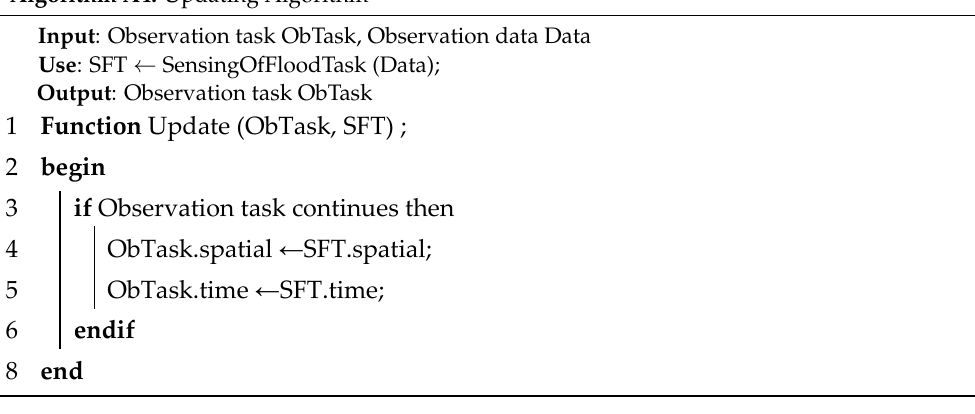
Algorithm A4: Updating Algorithm